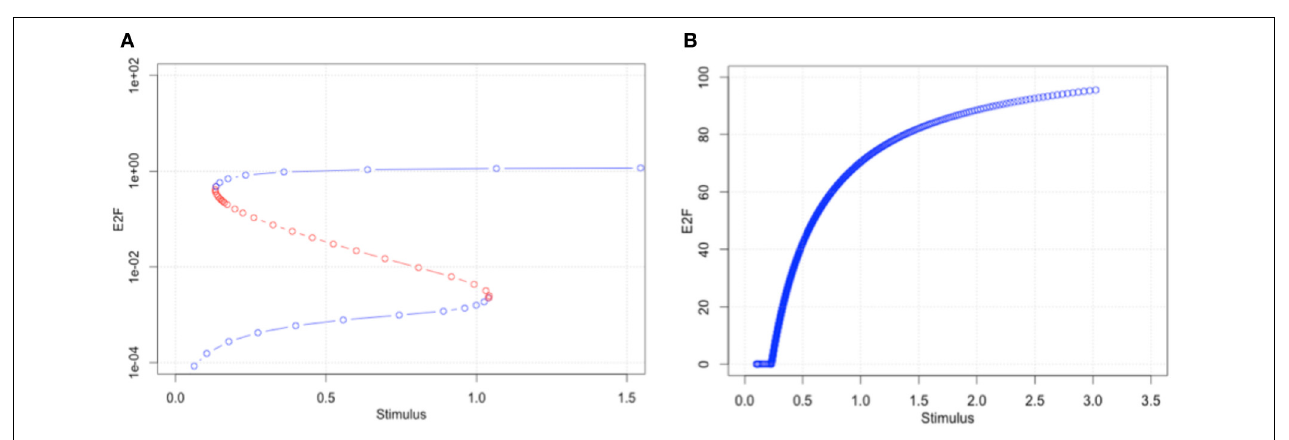
FIGURE 5 | The first bifurcation analyses with original parameter set (A) and optimized parameter set (B). The original parameter set produced bimodality and showed a wide range of hysteresis. By optimizing parameters to a malignant cell condition, the model has lost bimodality (B)